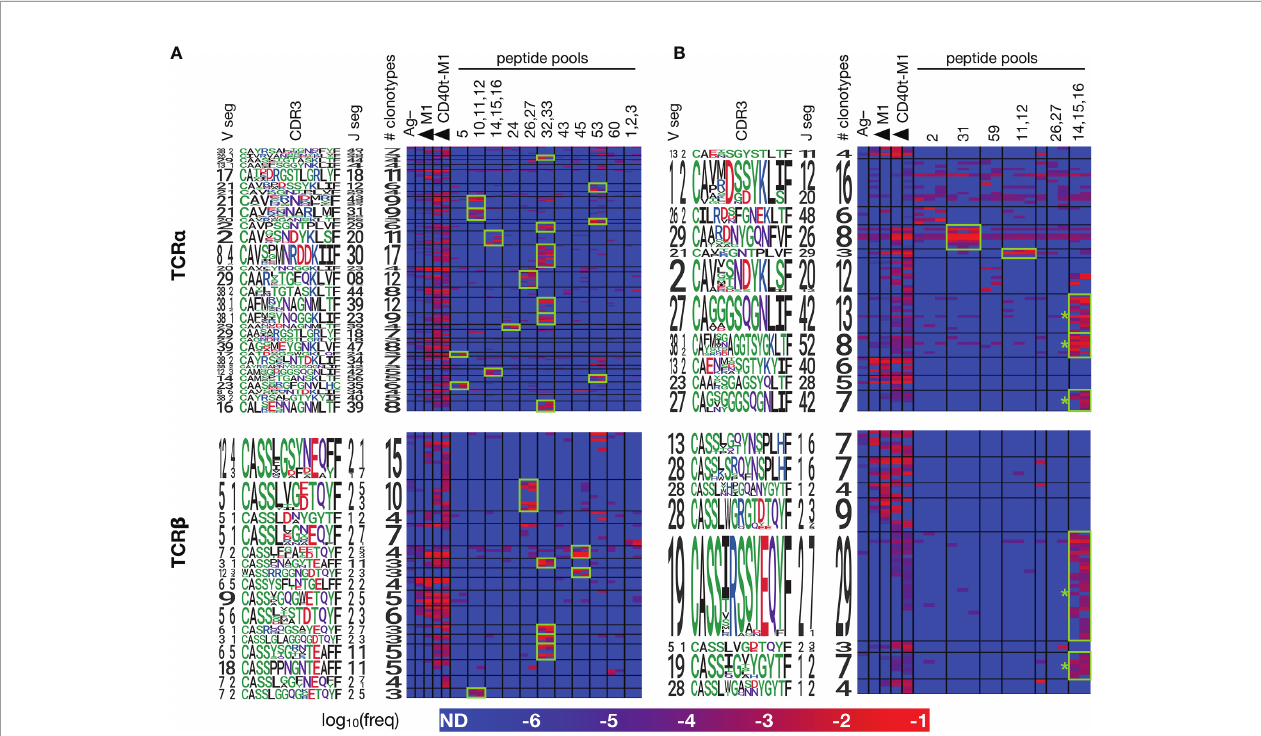
FIGURE 5 | Members of each CET show coordinated responses that distinguish different forms of antigen. PBMCs from ND1004 and ND1005 (A, B) , respectively) were expanded in replicate cultures with in fl uenza M1 antigen in a variety of forms – untargeted or CD40-targeted whole protein, or pools of overlapping peptides corresponding to the reactive epitopes identi fi ed in Figure 4, and then analyzed by TCR sequencing and CET identi fi cation as described previously. Signi fi cant CETs were identi fi ed in each sample individually, aggregated across all samples, and then re-clustered at the maximum TCRdist threshold of 50 for display. Each row represents a single clonotype, with CETs demarcated by horizontal black lines and labeled by logos representing their constituent V, CDR3, and J sequences. Each column represents a single culture, with conditions demarcated by vertical black lines (one replicate per column). Shown are CETs with ≥ 3 members and ≥ 100X average enrichment in any condition over the Ag – condition; highlighted in green are CET:peptide combinations with ≥ 100X average enrichment over the Ag – condition. * = CETs whose sequence features closely match TCRs previously described to recognize the HLA-A2-restricted GILGFVFTL antigen